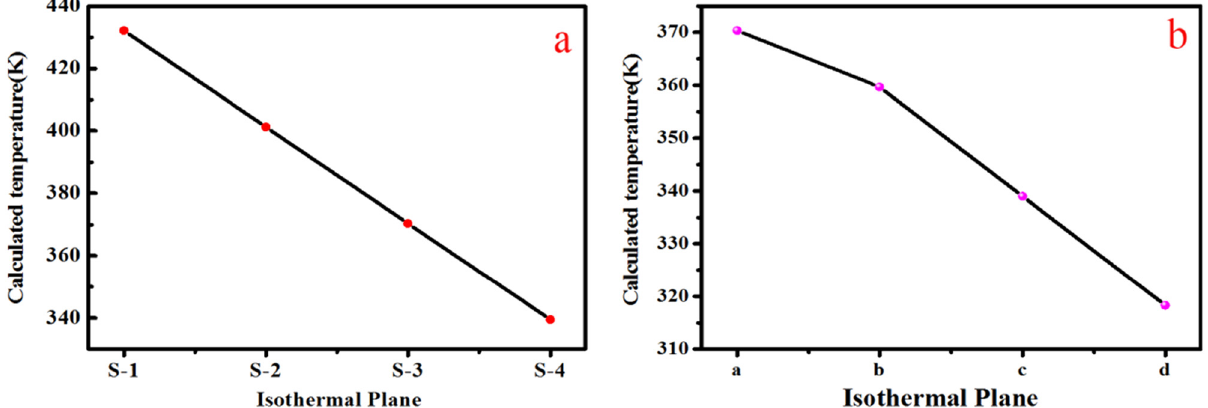
Figure 4: Calculation of the thermal transfer direction inside the foamed PP composites: ( a ) di ff erent isothermal planes and ( b ) di ff erent regions of the same isothermal plane.